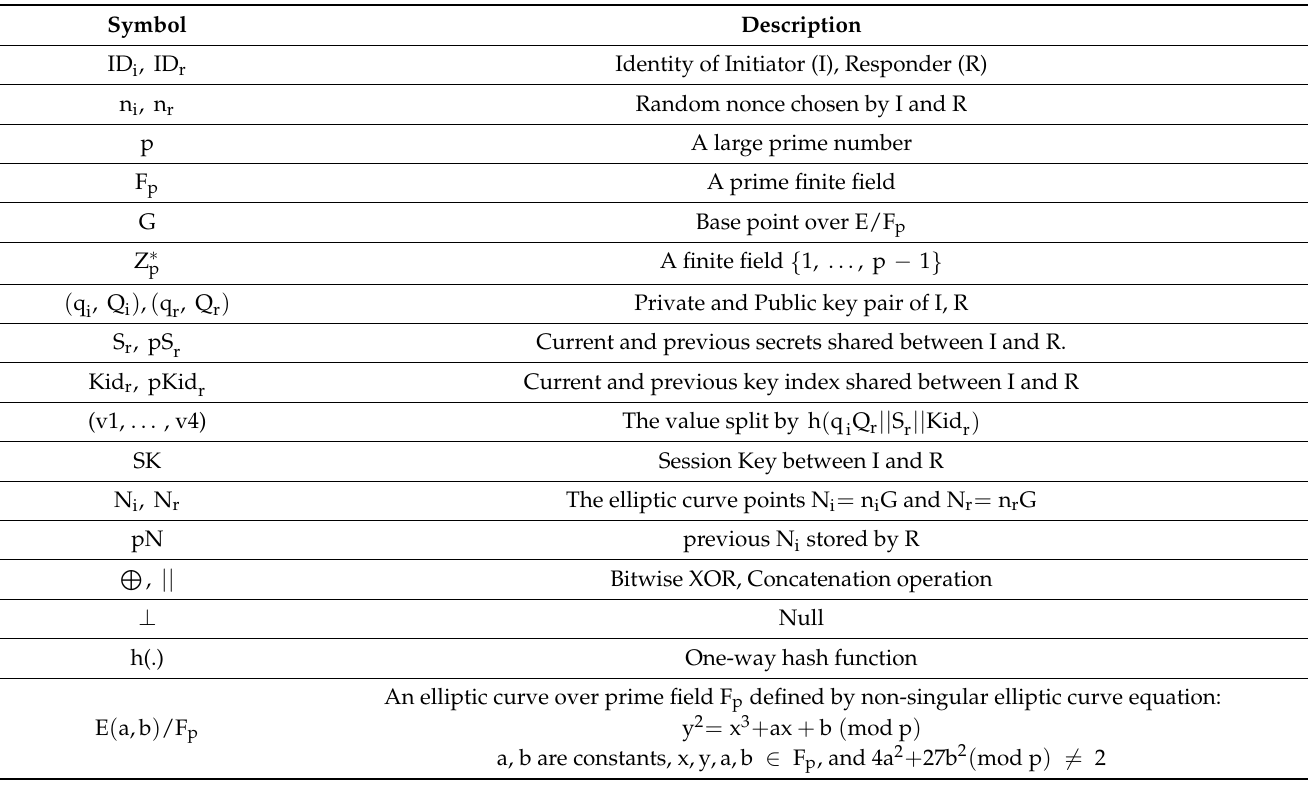
Table 1. Notation and